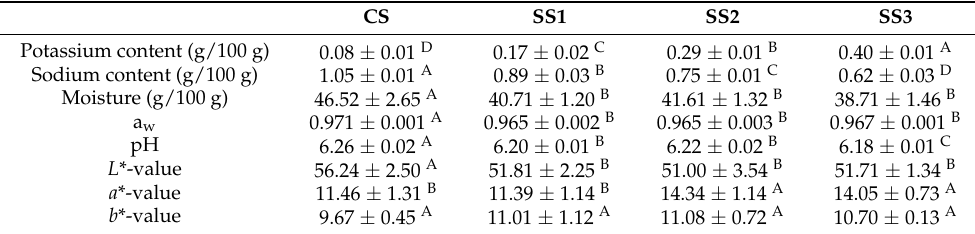
Table 1. Influence of the partial replacements of NaCl by KCl on the Na + and K + contents, moisture, water activity, pH, and color of